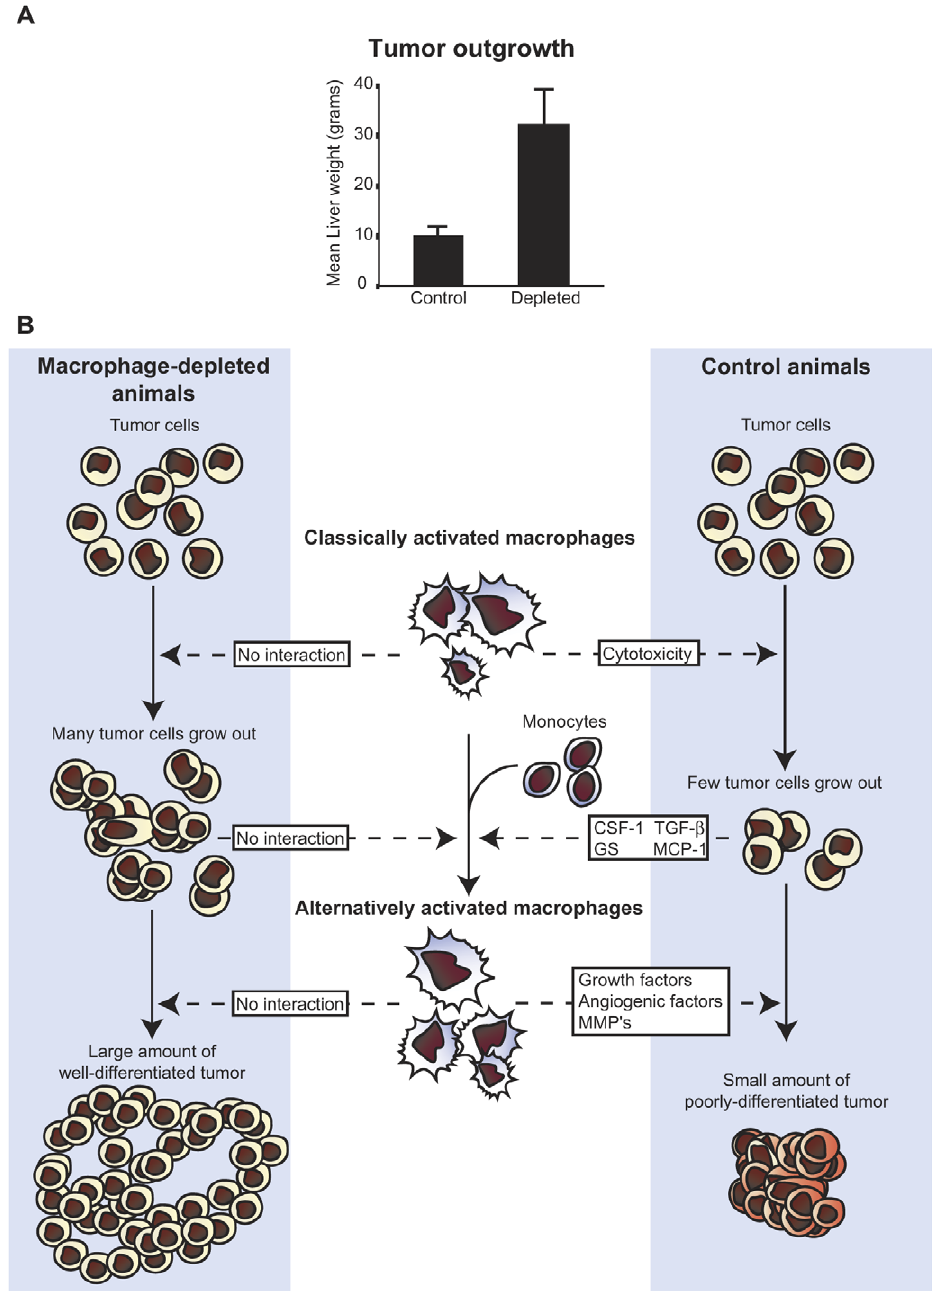
Fig. 3. (A) Tumor outgrowth in the liver increased dramatically when Kupffer cells (liver macrophages) had been depleted prior to inoculation of tumor cells in the portal vein. Total liver weight of Kupffer cell-depleted and control rats is shown. (Adapted from Heuff et al., 2003.) (B) Schematic model of the proposed role of macrophages in tumor outgrowth. Left: depleted animals. Due to the absence of macrophages, the majority of injected tumor cells grow out, which results in a large tumor load. However, presence of growth and angiogenic factors is reduced, leading to well differentiated tumor. Right: control animals. After injection of tumor cells, a large fraction of the cells is killed by macrophages, resulting in outgrowth of few tumor cells. However, the tumors that do develop promote the generation of alternatively activated macrophages, either by recruitment of new monocytes or by conversion of already present macrophages. These in turn can stimulate tumor growth and angiogenesis, which leads to poorly differentiated